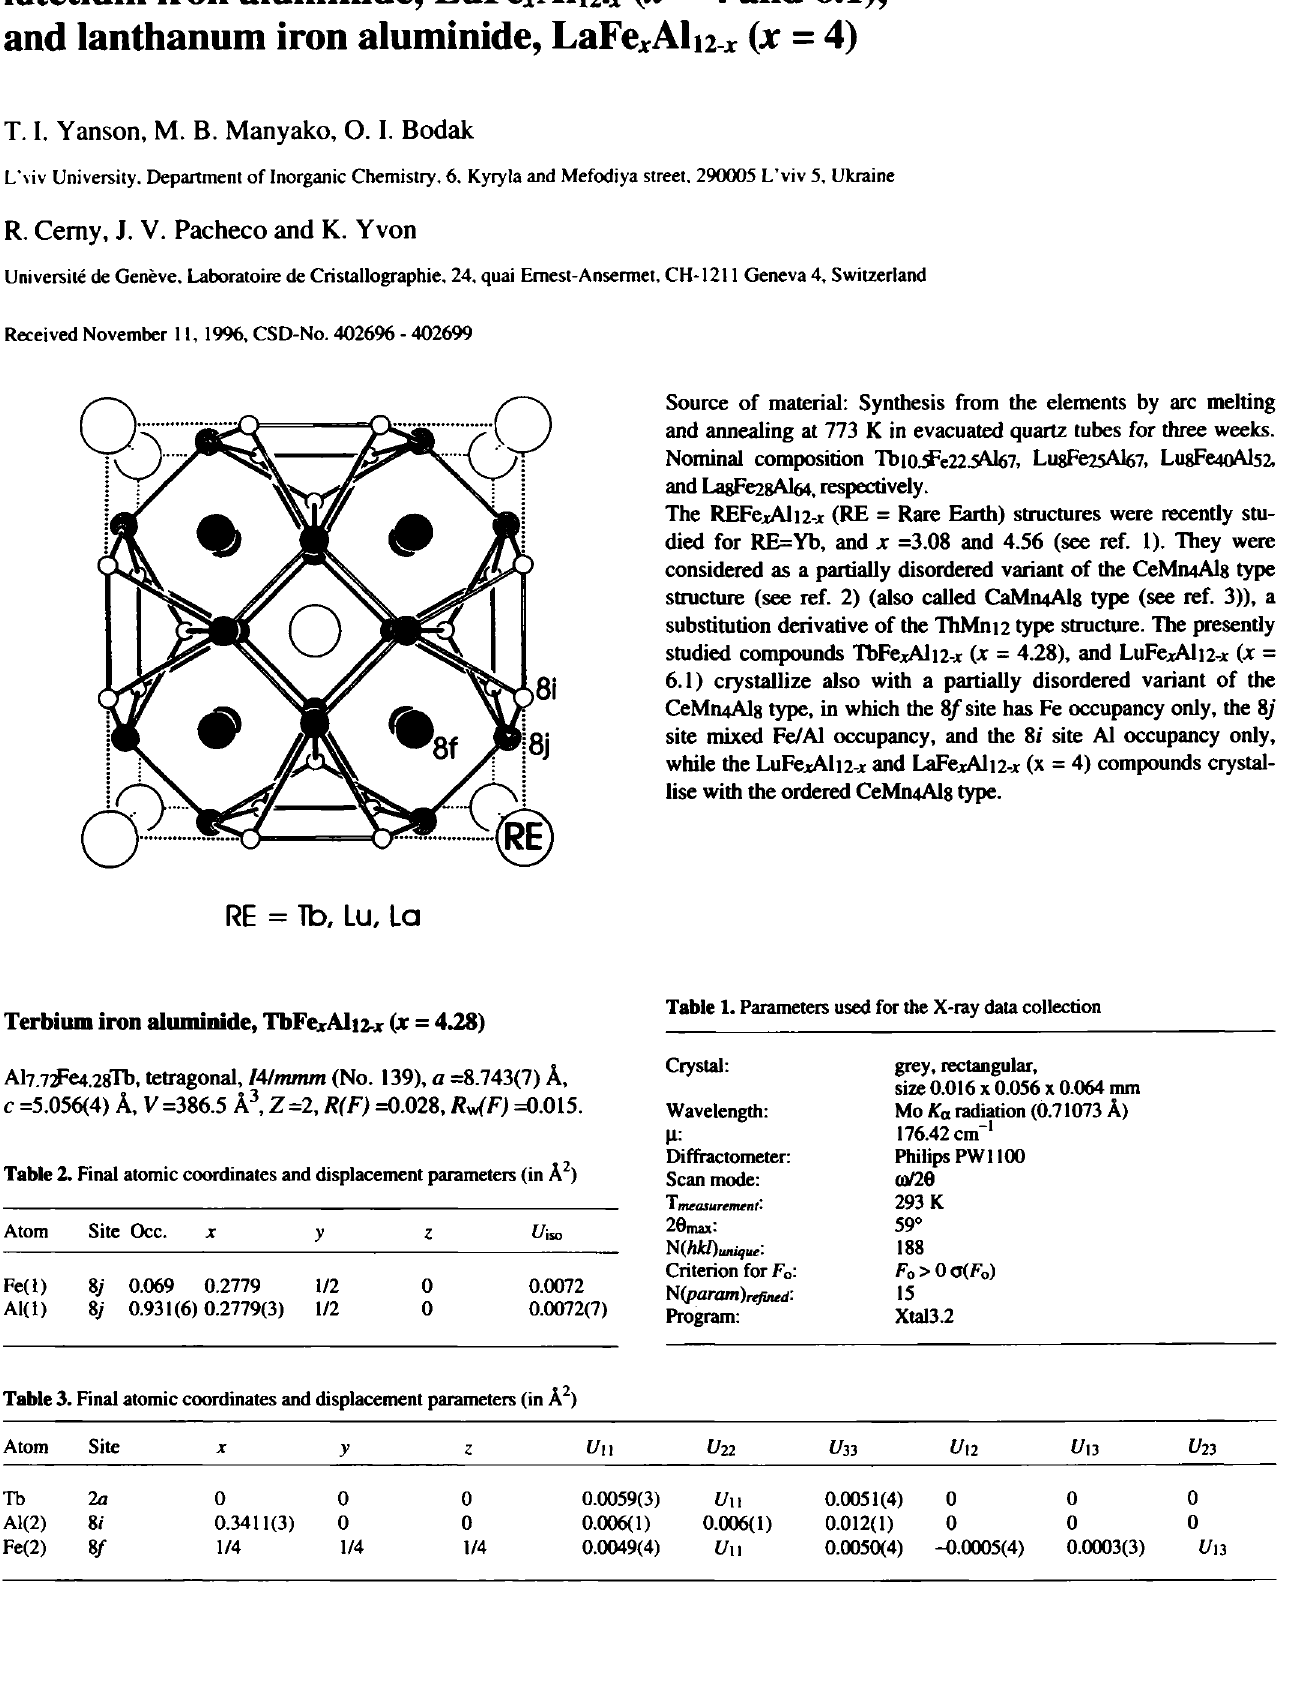
Table 2. Final atomic coordinates and displacement parameters (in Â 2 ) Atom Site Occ.